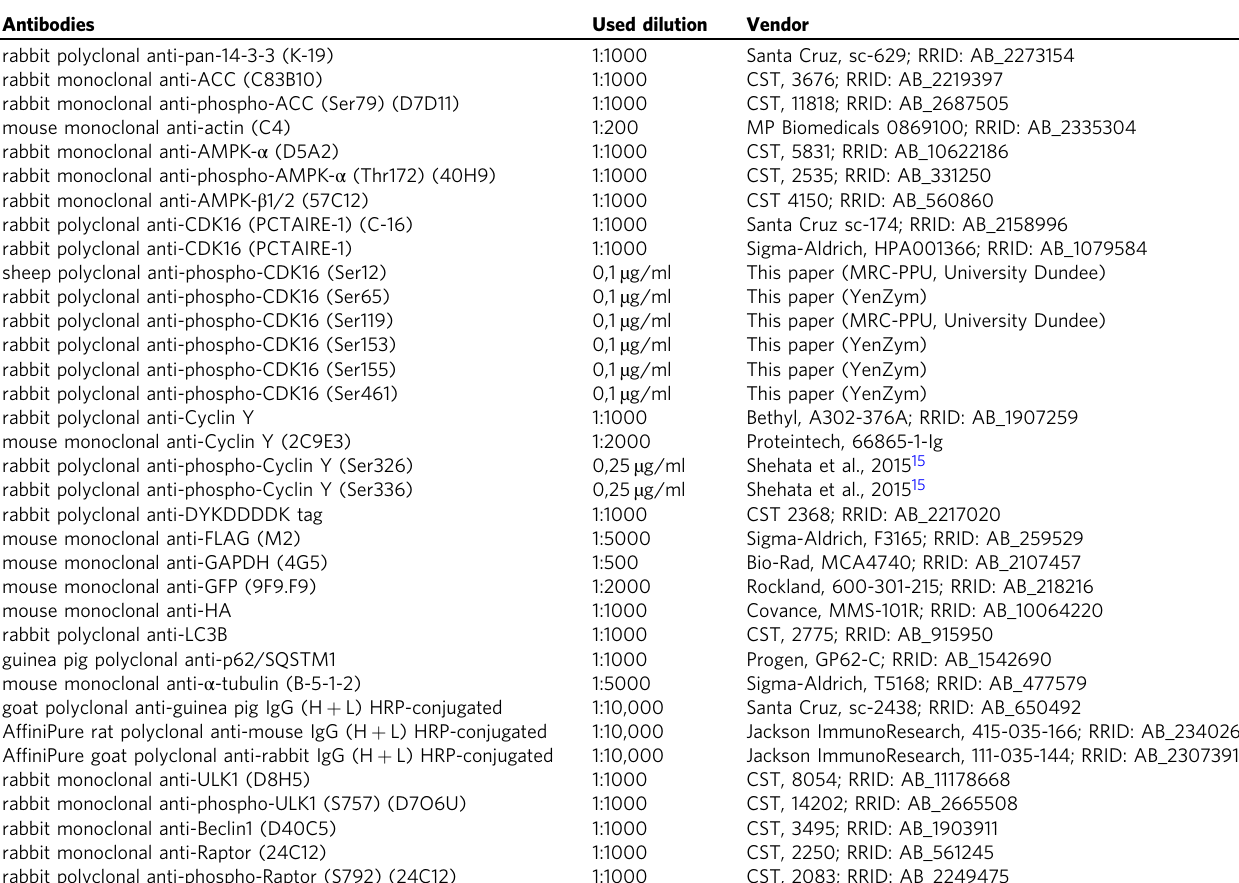
Table 1 Antibodies used for western blots. Antibodies Used dilution Vendor rabbit polyclonal anti-pan-14-3-3 (K-19)